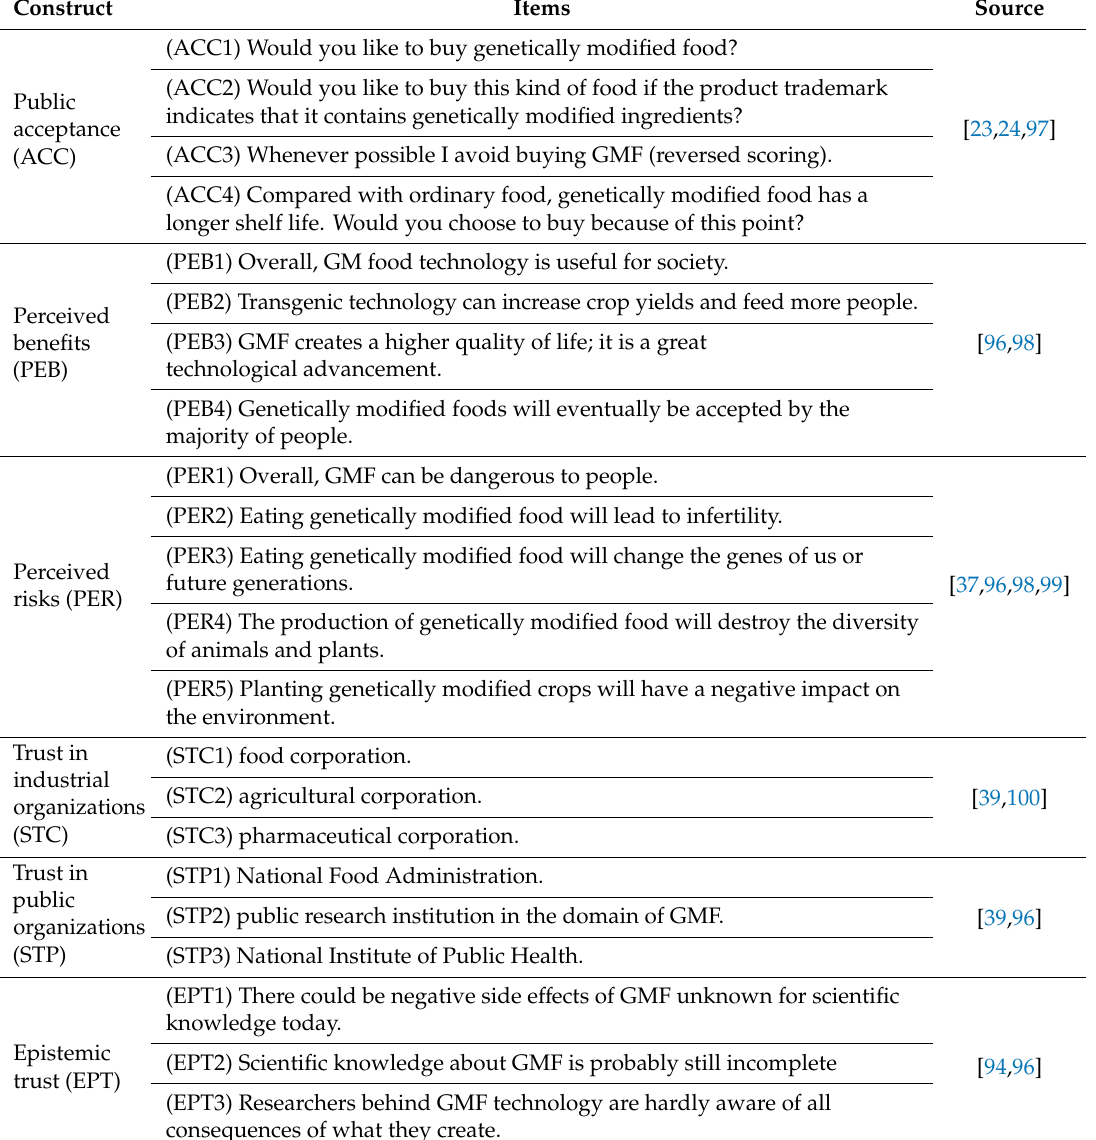
Table 1. Measures used in the